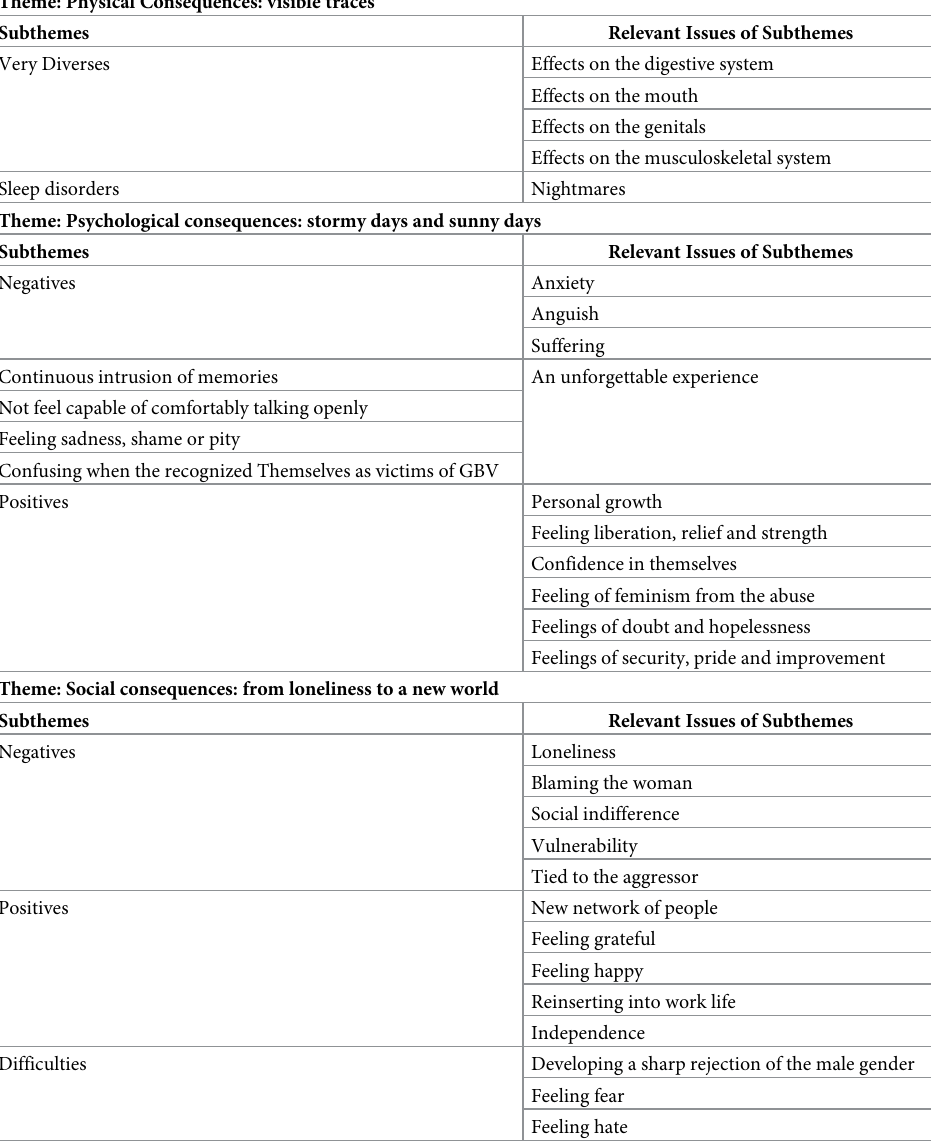
Table 3. Results: Themes and